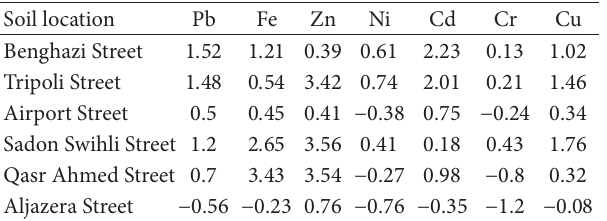
Table 2: Geoaccumulation index of heavy metals in soil in the areas of